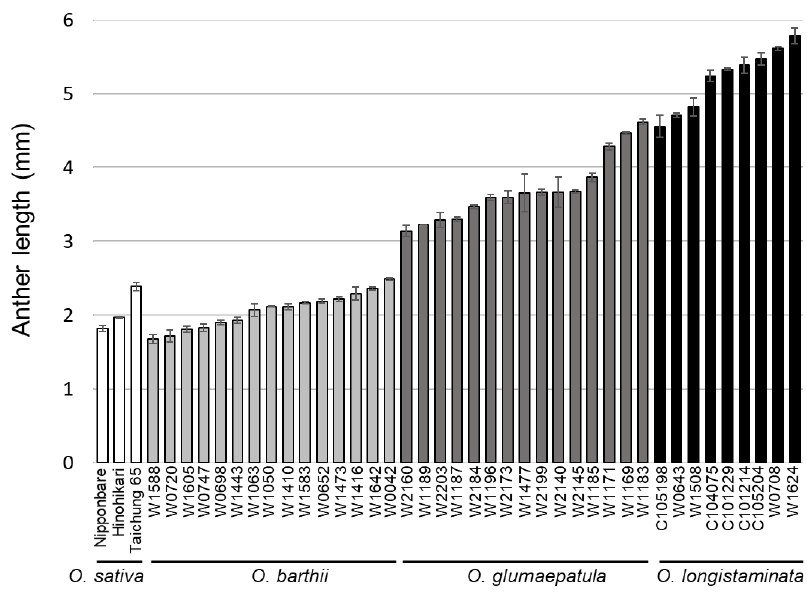
Figure 1. Distribution of anther length (mm) in cultivars of O. sativa and accessions of O. barthii , O. glumaepatula , and O. longistaminata . Mean ± SE, n = 3.